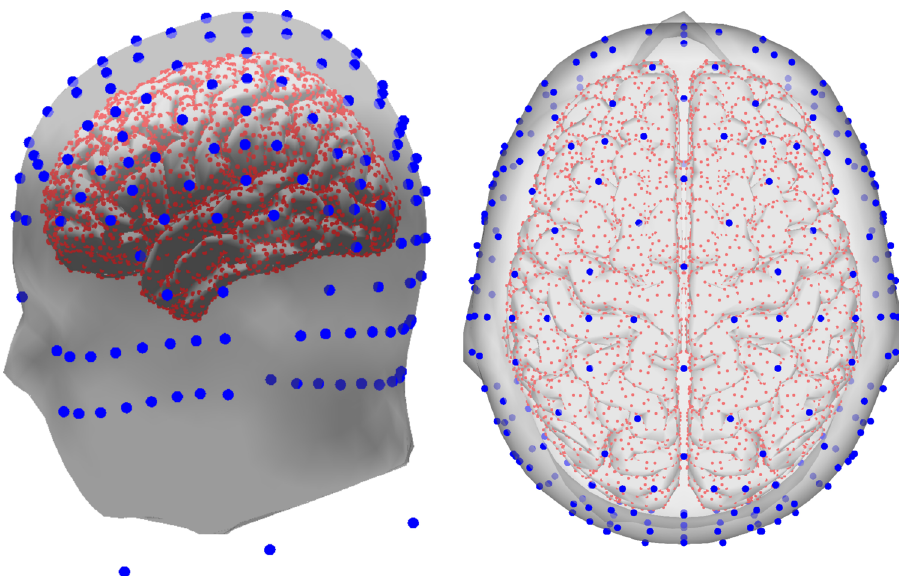
Figure 4. New York head model with 10,000 sources and 231 channels 40 . Lateral view (left) and top view (right). The blue circles represent the location of the EEG channels over the scalp, face, and neck, while the red circles represent the location of the distributed sources on the brain’s cortical